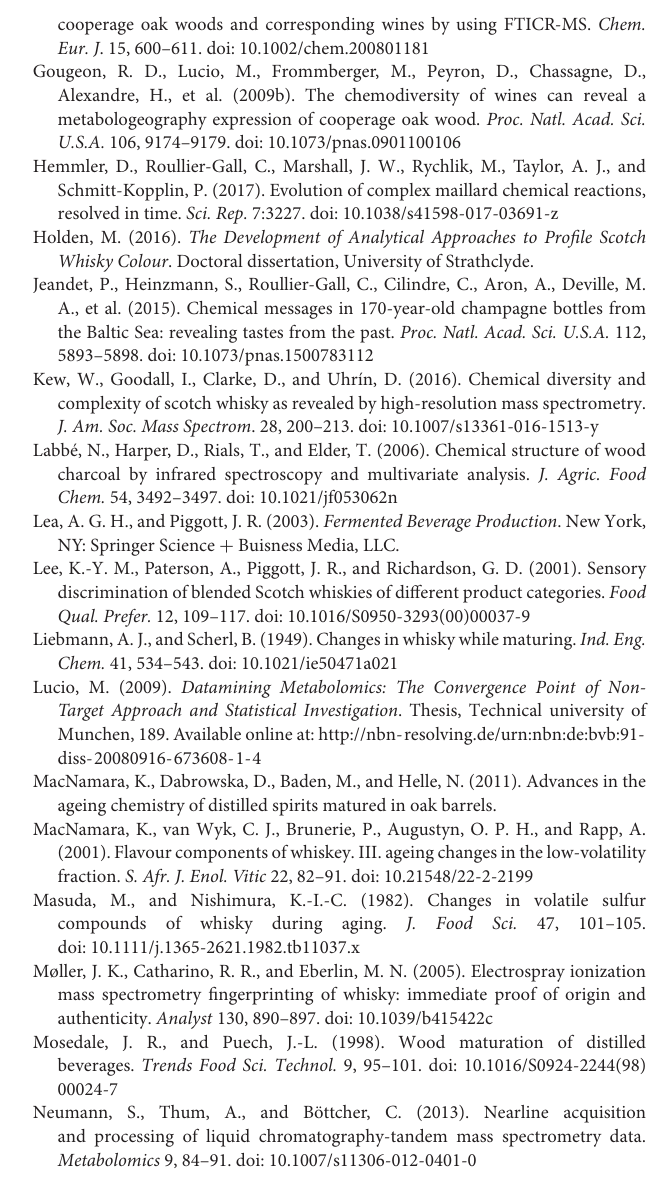
and gallic acid standards. Supplemental Table 1 | Tables of the 150 whiskies samples. Supplemental Table 2 | Tables of the 4 rums samples. Supplemental Table 3 | Key features discriminating Bourbon (BB— Figure 3C ) and Sherry (SB— Figure 3D ) cask matured whiskies based on